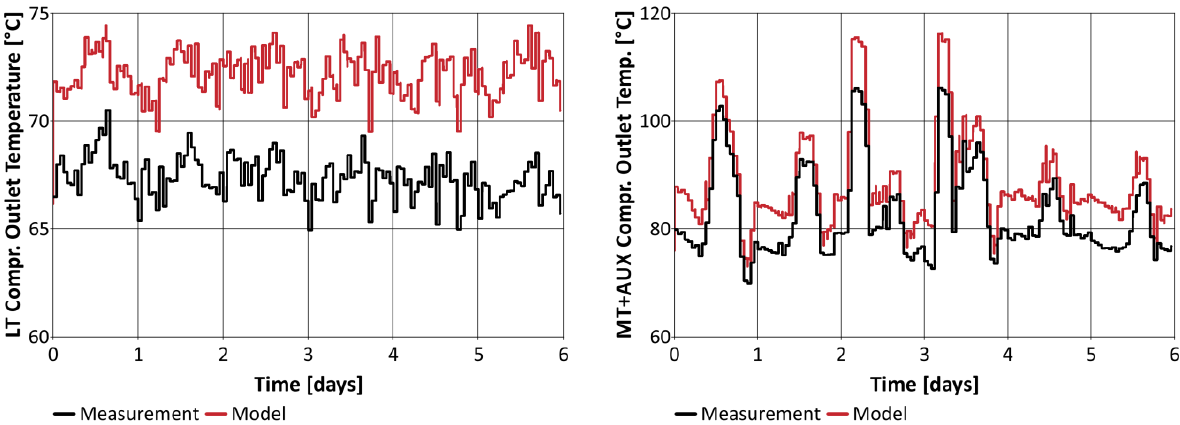
Figure 8. Validation results for the compressor modeling approach; comparison between calculated vs. measured compressor outlet temperature in °C for LT and MT + AUX compressors.